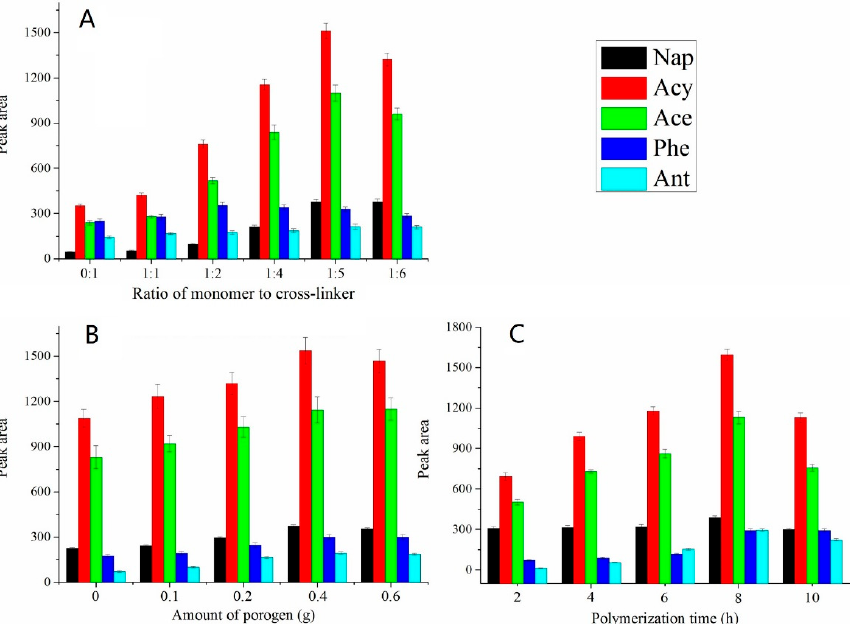
Figure 2. Effects of the SPME fiber preparation conditions on extraction efficiency: ( A ) molar ratio of monomer to cross-linker (amount of porogen: 0.4 g, polymerization time: 8 h), ( B ) amount of porogen (monomer: cross-linker = 1:5, polymerization time: 8 h) and ( C ) polymerization time (monomer: cross-linker = 1:5, amount of porogen: 0.4 g).